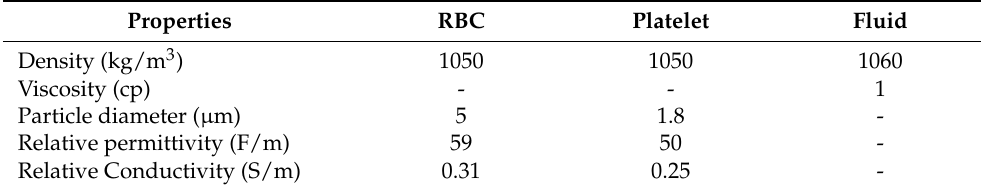
Table 1. Material and dielectric properties of the cells and